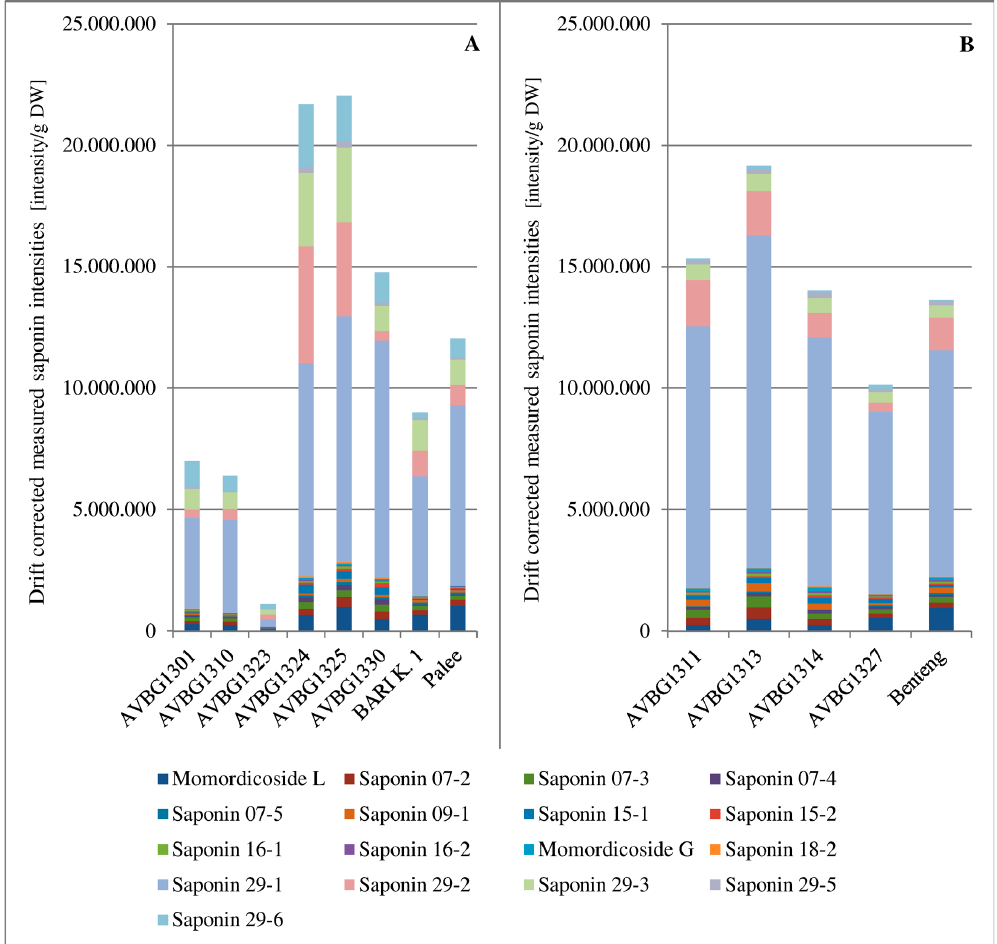
Fig. 2: LC-MS intensity distributions of saponins in eight South Asian (A) and five Southeast Asian (B) type bitter gourd entries cultivated in a greenhouse in Karlsruhe, Germany. BARI K. 1 = ‘BARI Karella 1’, DW = dry weight. Momordicoside denotations are based on a laboratory internal numbering with the exceptions of L and G. Means of 10 fruits per